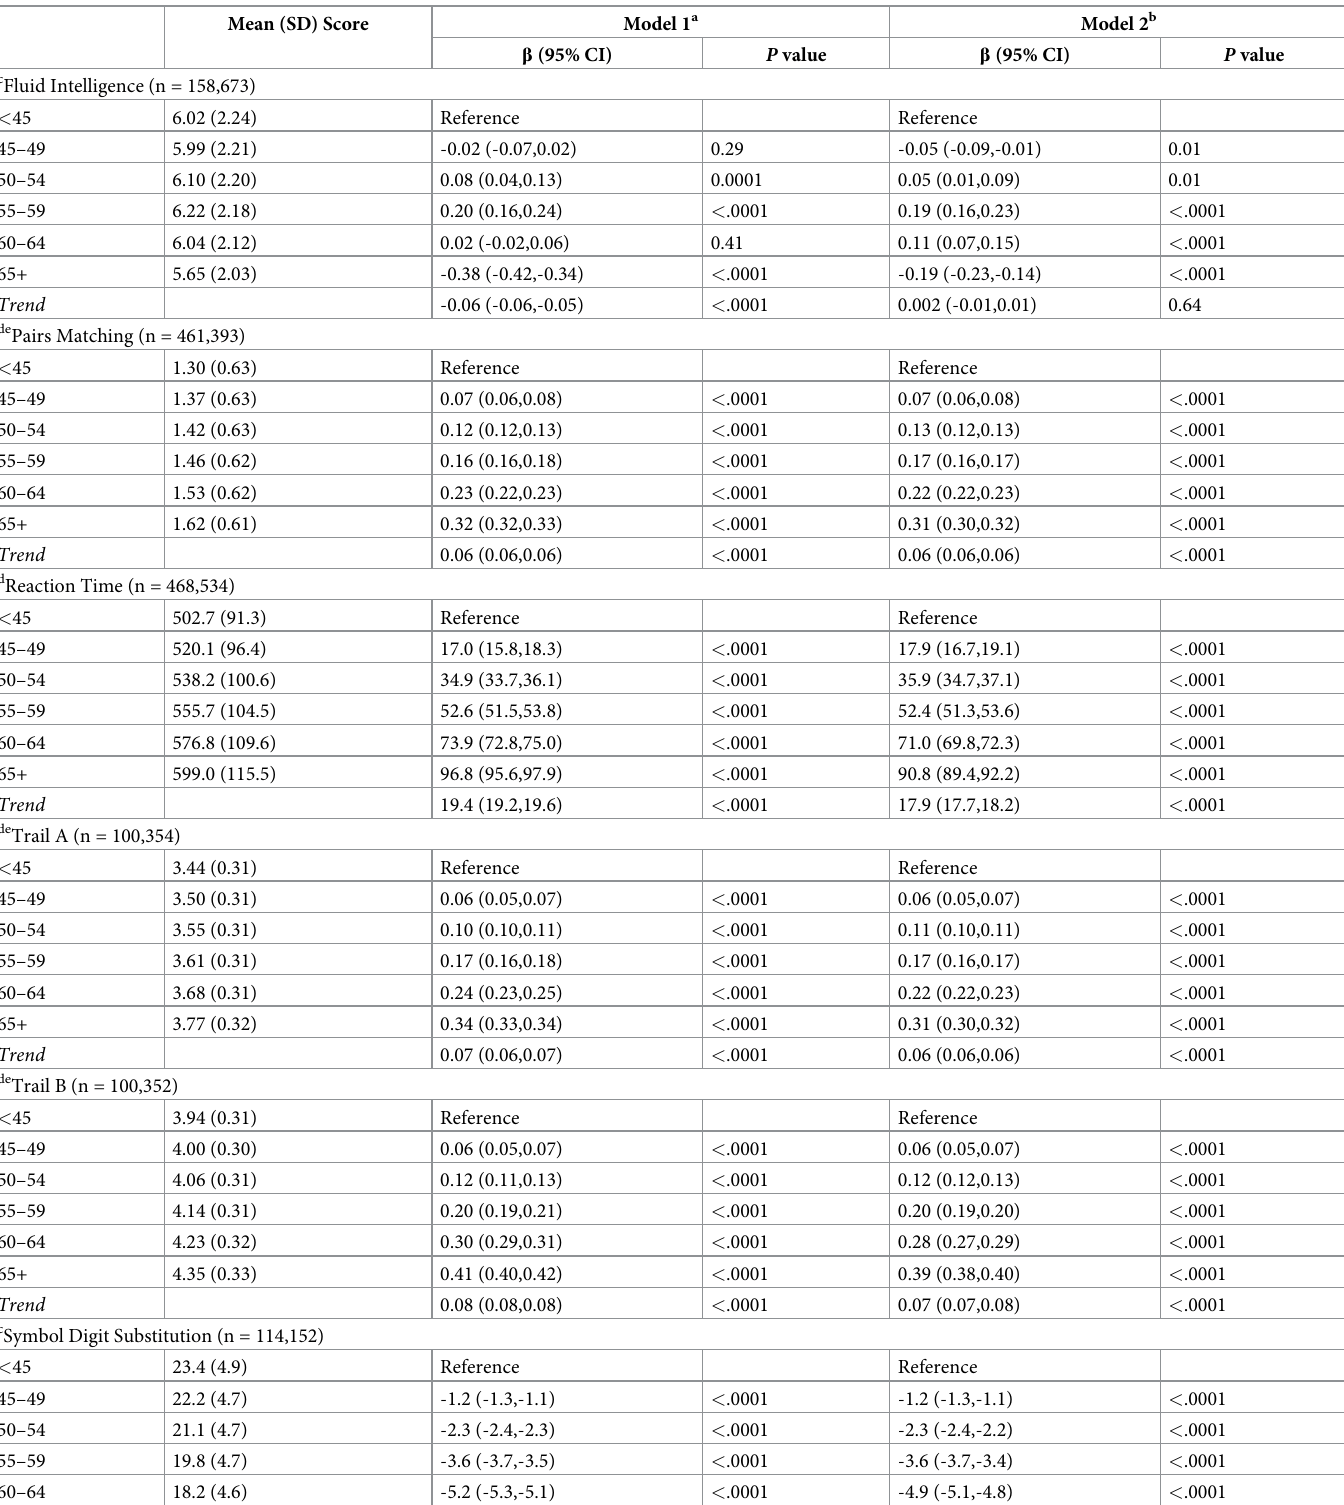
Table 2. Cross-sectional associations between age and cognitive function tests measured at baseline